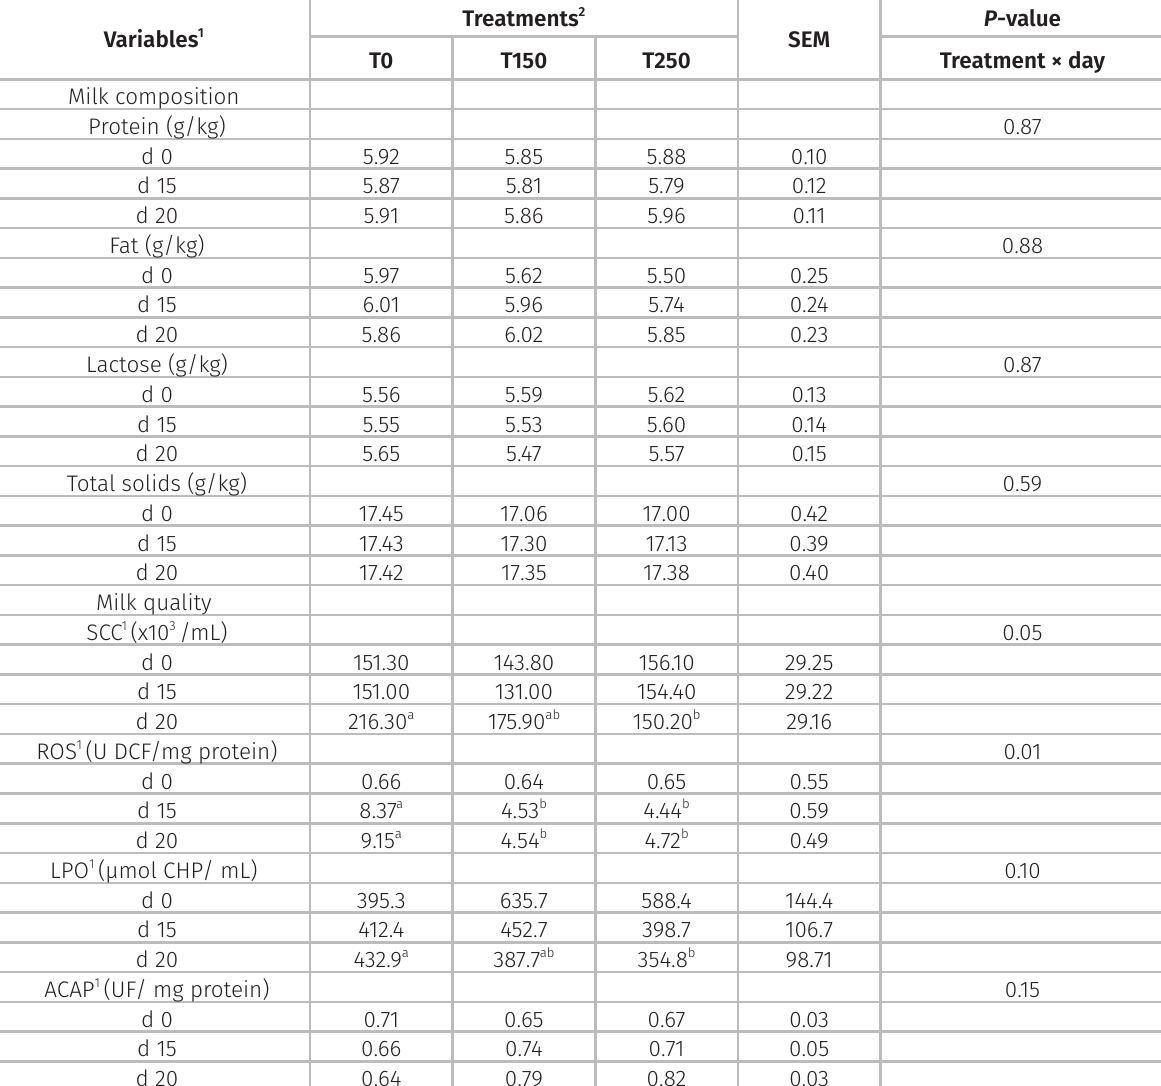
Table III. Milk composition and quality of Lacaune ewes supplemented with dietary phytogenic. Variables